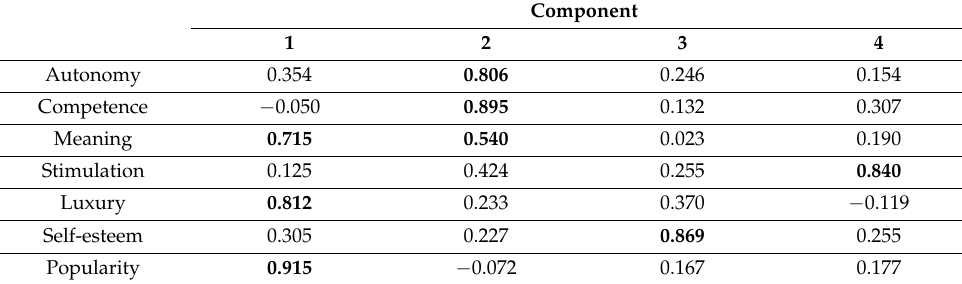
Table 2. Varimax rotation results of principal components of UX